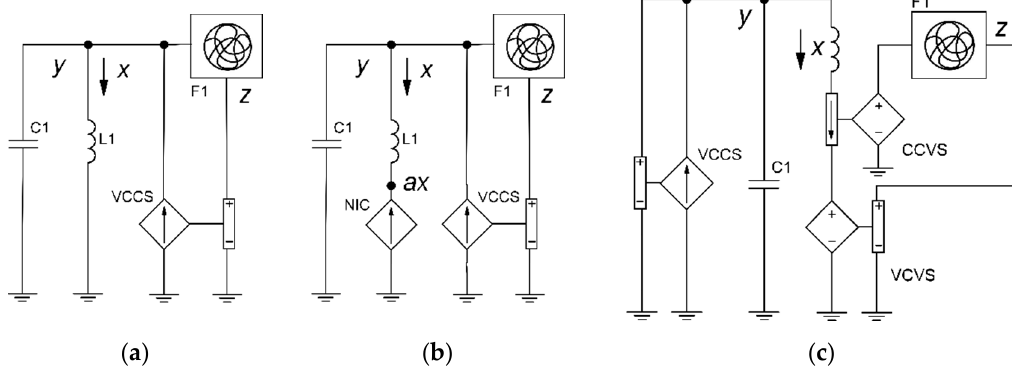
Figure 1. Circuits based on the LC tank: ( a ) simple (e.g., Sprott Case N), involving ( b ) passive or active impedance converter (e.g., Sprott Case H) and with ( c ) current feedback (e.g., Sprott Case M). VCCS, voltage-controlled current source; NIC, negative impedance converter; CCVS, current-controlled voltage source; VCVS, voltage-controlled voltage source; F1, block with the integrator and nonlinear operation.